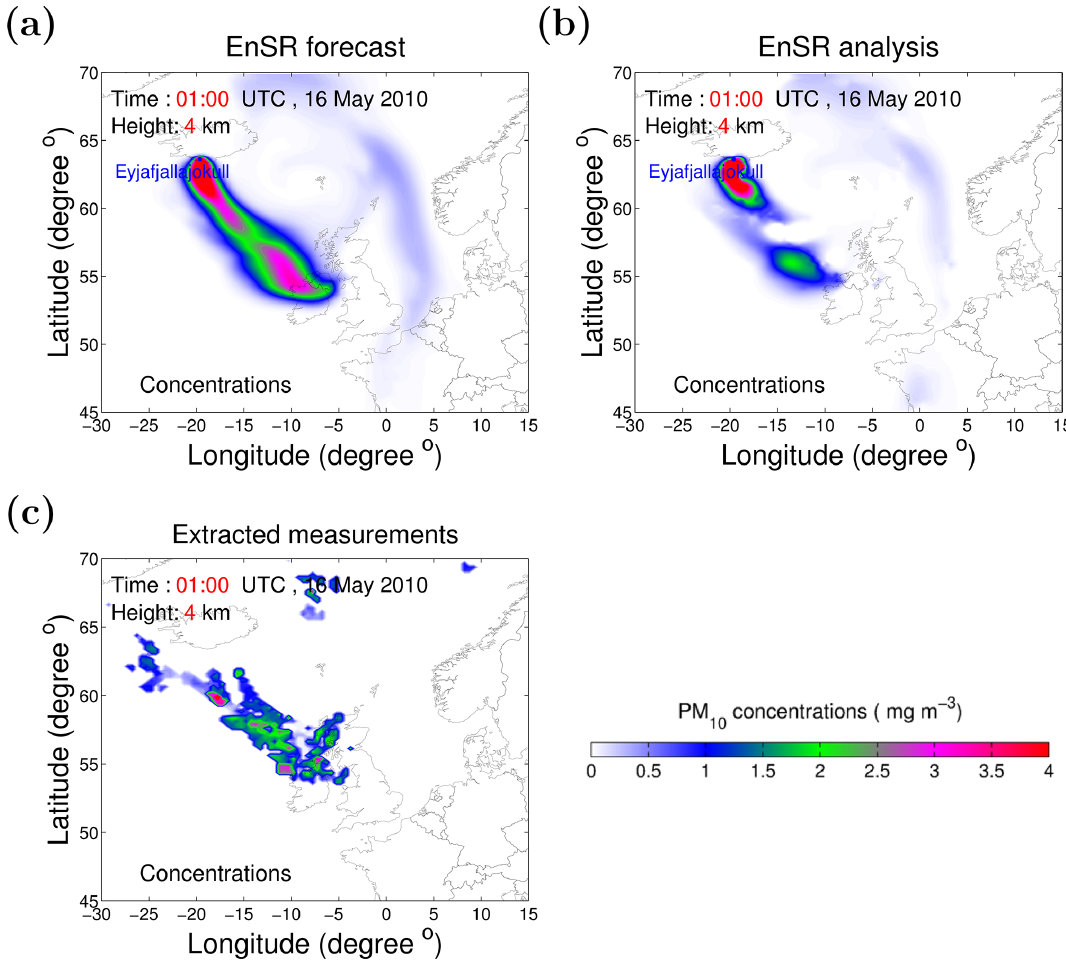
Figure 4. Examination of EnSR effect when assimilating SEVIRI-extracted ash concentrations at 01:00UTC 16 May 2010. (a) EnSR forecast (ensemble mean) of PM 10 concentrations. (b) EnSR analysis (ensemble mean) of PM 10 concentrations. (c) Extracted measurements of PM 10 concentrations from the SOO. (a) , (b) , ( c) are illustrated at a height of